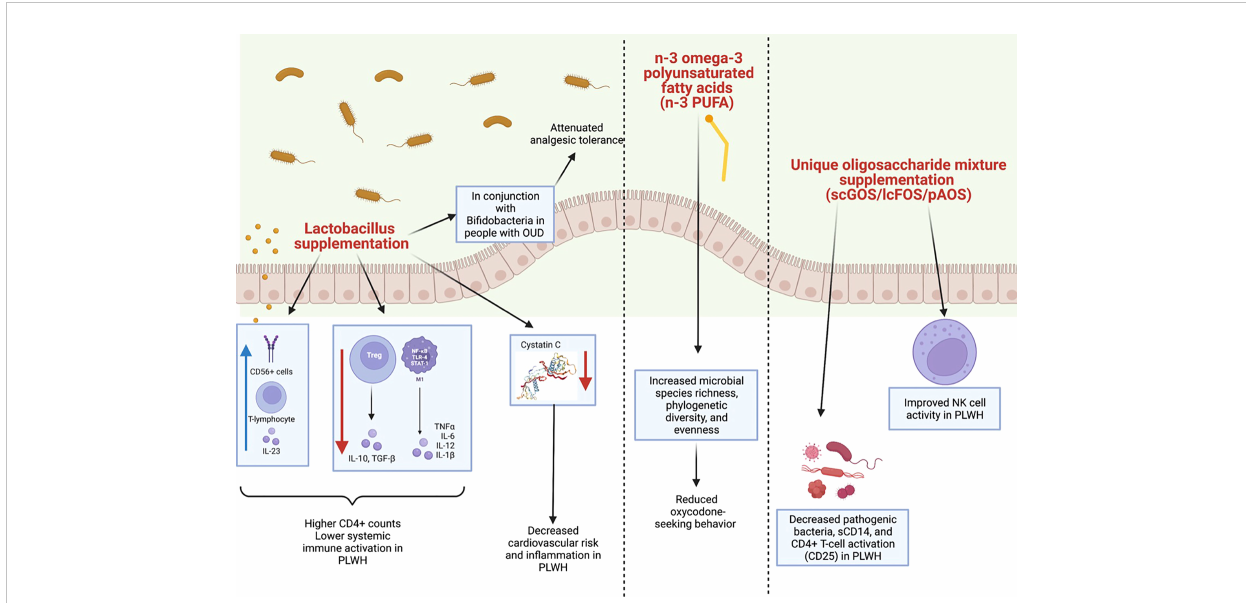
FIGURE 4 Summary of clinical and preclinical studies detailing the impact of probiotics with HIV or opioid use. (Left panel) Lactobacillus supplementation has been shown to have a positive impact on the microbiomes of both clinical and preclinical models of HIV or opioid use. In PLWH, Lactobacillus supplementation has been shown to increase CD56+ cells, T-lymphocytes, and IL-23 and to decrease levels of TGF b , IL-10, IL-12 and IL-1 b . This is thought to lower systemic immune activation and to increase CD4+ counts in PLWH. Lactobacillus supplementation also decreases cystatin C (image from https://www.sinobiological.com/resource/cystatin-c/proteins) which in turn, decreases cardiovascular risk and in fl ammation in PLWH. Lactobacillus supplementation in conjunction with Bi fi dobacteria supplementation also has been shown to attenuate analgesic tolerance in morphine-treated mice. (Middle panel) Additionally, in preclinical models of chronic opioid use, an n-3 omega-3 polyunsaturated fatty acids (n-3 PUFA) enriched diet increased species richness, phylogenetic diversity, and evenness, as well as decreased oxycodone-seeking behaviors. (Right panel) Lastly, a unique oligosaccharide mixture supplementation including short-chain galacto-oligosaccharides (scGOS), long-chain fructo- oligosaccharides (lcFOS), and pectin hydrolysate derived acidic-oligosaccharides (pAOS) in PLWH has been shown to decrease pathogenic bacteria, sCD14, and CD4+ T-cell activation in PLWH, as well as to improve NK cell